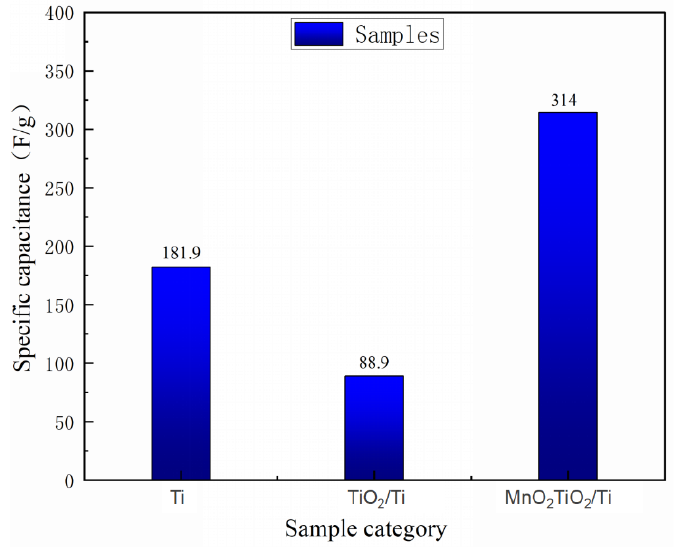
Figure 7. Histogram of specific capacitance values of metal porous Ti, surface-modified TiO 2 /Ti, and MnO 2 /TiO 2 /Ti nano composites.